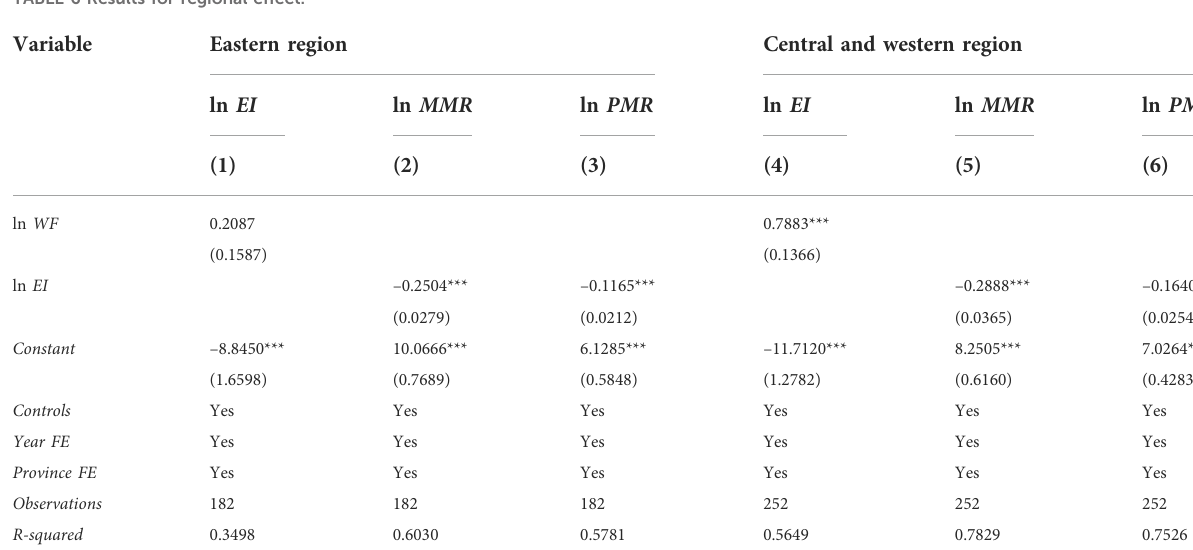
TABLE 6 Results for regional